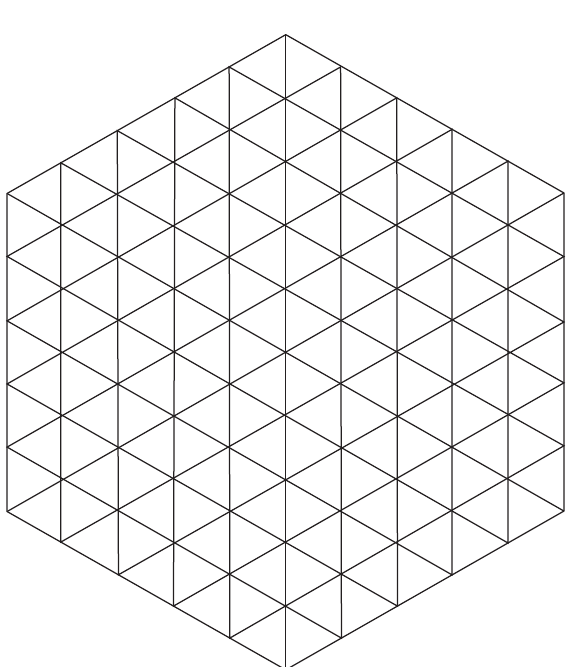
Figure 3: The hexagonal networks H